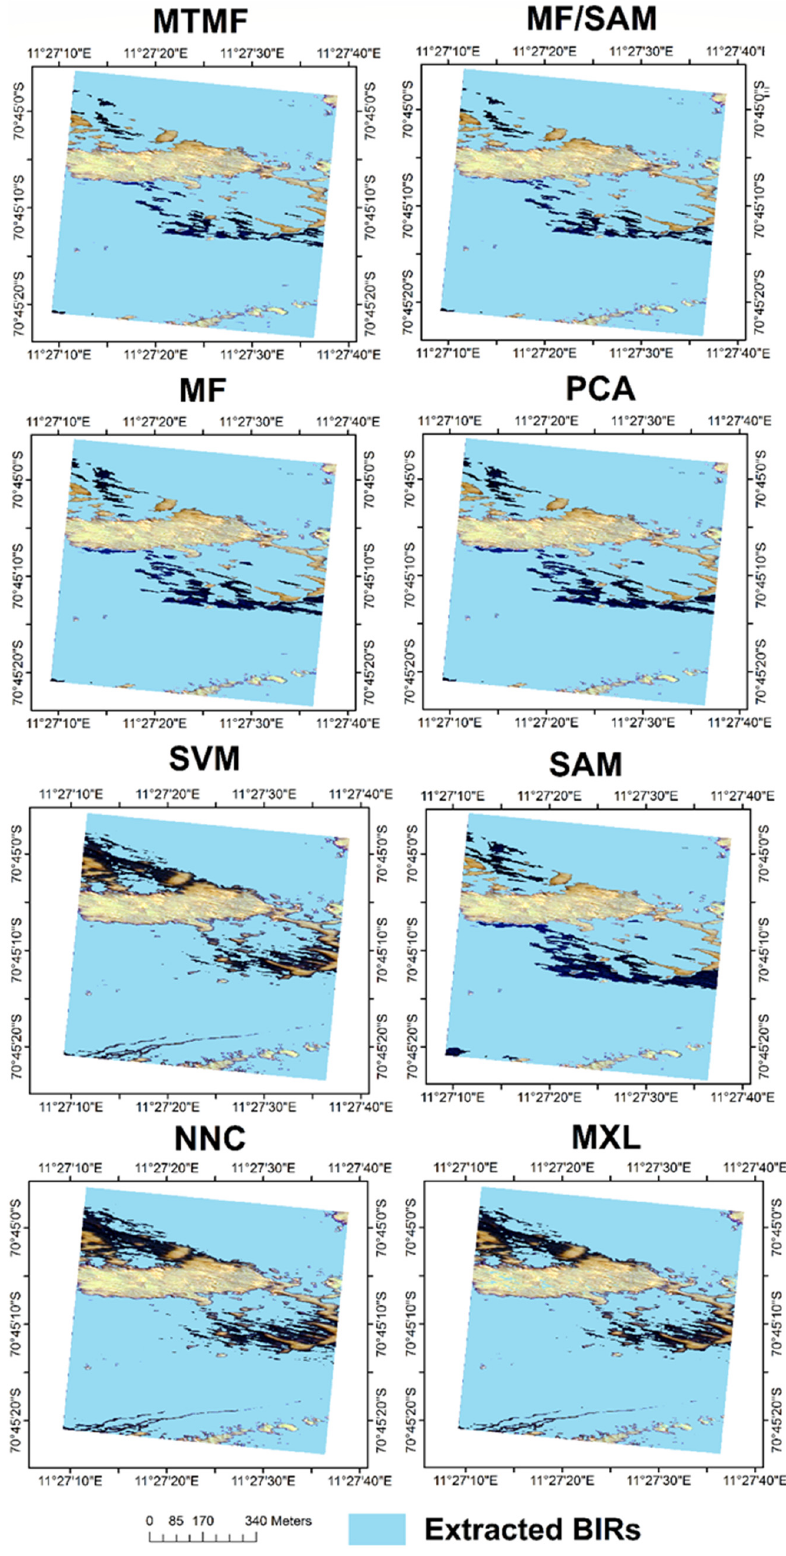
Figure 7. A visual image analysis of extracted BIRs from the sample Tile-1 using four spectral processing methods under the SP approach and four supervised pixel-wise classification methods under the PSC approach. Extracted BIR patches are appended on the WorldView-2 image (RGB: 8,5,1 band combination). The dark blue patches visible on images are non-BIRs.